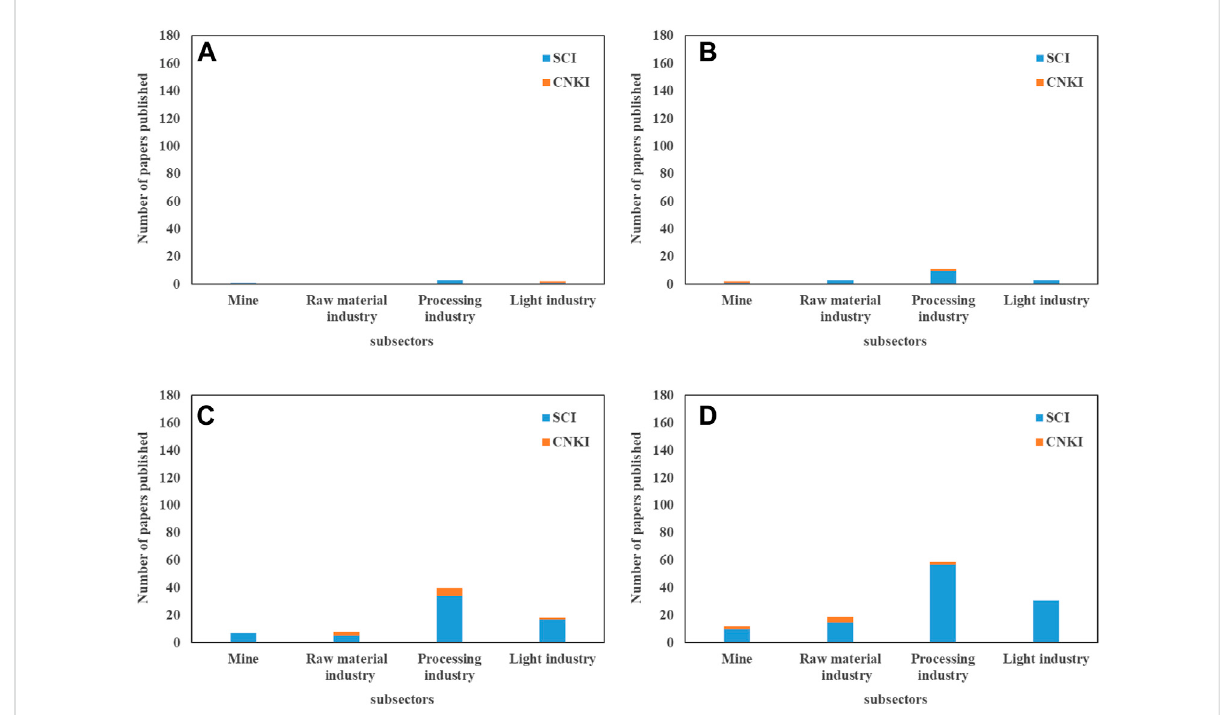
The number of relevant papers related to the industrial sector (A) Before 2010. (B) 2010 – 2013. (C) 2014 – 2017. (D) 2018 –